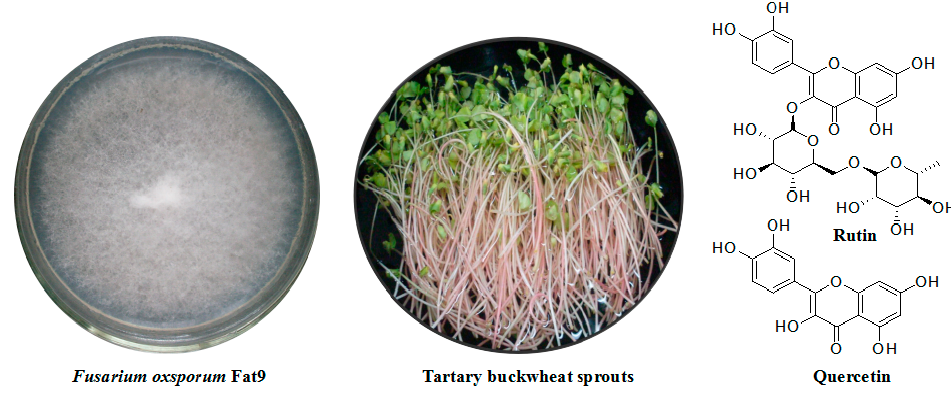
Figure 1. Endophyte F. oxysporum Fat9, sprouts and main flavonoids of F. tataricum .